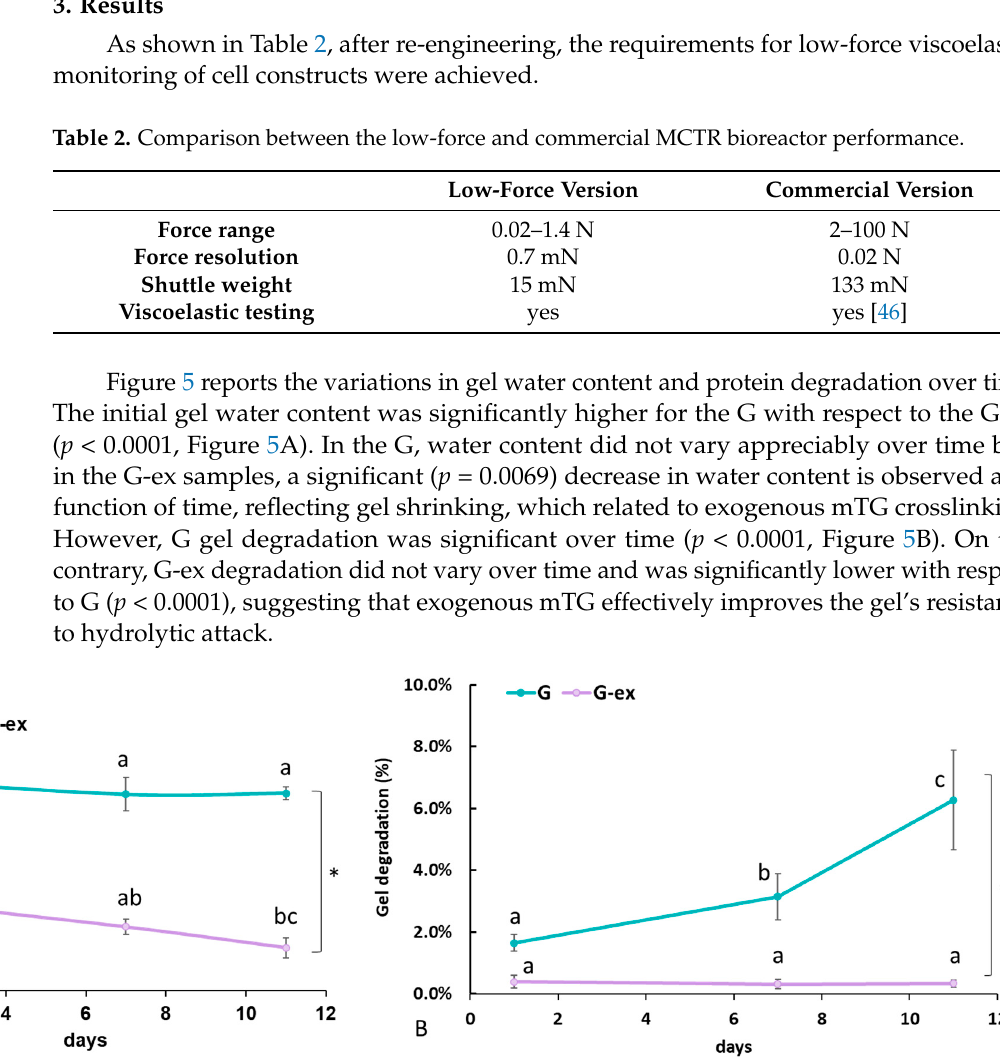
Figure 5. ( A ) Water content, calculated as the percentage of the total initial mass of the gel; ( B ) Gel degradation, expressed as the percentage of protein content in the supernatant with respect to the initial protein content (* = p < 0.5). For each gel type, different letters indicate significant differences over time ( p < 0.5).